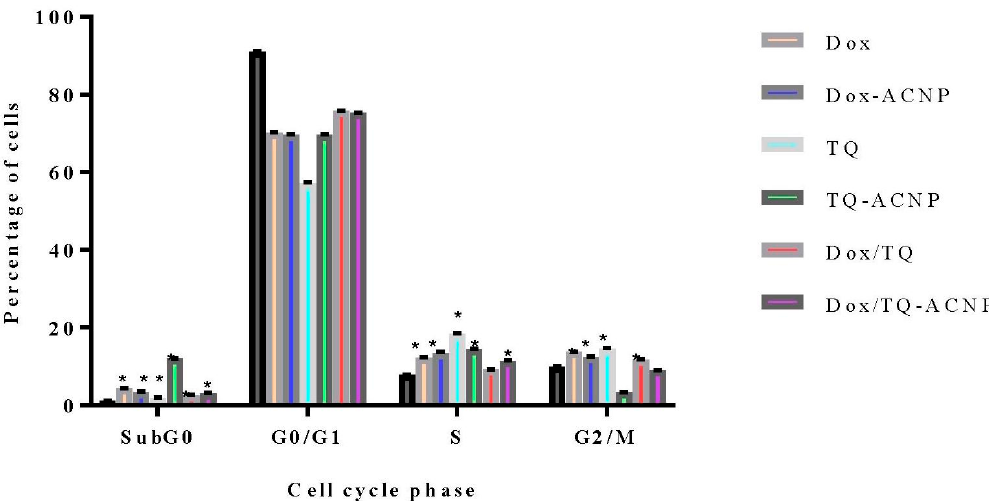
Figure 19. Graphical representation of the effect of various treatments on the cell cycle distribution of 3D mammosphere cells at 48 h.* p < 0.05 significant increase compared to control. All of the treatment caused significant S phase arrest by increasing its cell population from 7.8% (Control) to 12.15% (Dox), 13.4% (Dox-ACNP), 18.35% (TQ), 14.4% (TQ-ACNP), 9.15% (Dox/TQ) and 11.4% (Dox/TQ-ACNP). TQ and TQ-ACNP had the largest effect on S phase (18.35% and 14.4% increase in cell population, respectively), while Dox/TQ-ACNP and Dox/TQ had the least effect (11.4% and 9.15%, respectively). The percentage of cells in the G2/M phase was increased in Dox, Dox-ACNP, TQ and Dox/TQ (13.6%, 12.3%, 14.55%, 11.7%, respectively) compared to control (9.8%), signifying cycle arrest in G2/M phase. After 48 h, all treatment options induced a significant increase in the subG0 cell population. 3. Materials and Methods 3.1. Preparation of ACNP and Drug loading The preparation of ACNPs, drug loading of thymoquinone (Tokyo chemical industry, Tokyo Japan) and doxorubicin (Cayman Chemical, Ann Arbor, MI, USA), characterization of Dox-ACNP, TQ-ACNP and Dox/TQ-ACNP were carried out in accordance with Ibiyeye et al. [48]. 3.2. Generation of 3D Mammosphere from MDA MB 231 For mammosphere culture, MDA MB 231 cells (ATCC, Manassas, VA, USA) with less than ten passages were grown to about 70%–80% confluence and then enzymatically detached with trypsin (Nacalai Tesque, Kyoto, Japan), gently pipetted and suspended into single cells and passed through a 40 µm cell strainer (Corning, Lowell, MA, USA). A quantity of 1 mL of MDA MB 231 cells suspension was cultured in 24 well ultra-low attachment plates (Corning, Lowell, MA, USA ) at 20,000 cells/mL in Mammocult complete media (Stem Cell Technologies, Vancouver, BC, Canada) supplemented with 4 µg/mL of heparin solution (Stem Cell Technologies, Vancouver, BC, Canada), 0.48 µg/mL hydrocortisone stock solution (Stem Cell Technologies, Vancouver, BC, Canada) , and 1% antibiotics (Nacalai Tesque, Kyoto, Japan). After 7 days of culture in the incubator in 5% CO 2 and at 37 °C, mammospheres were used for further experiment [29]. 3.3. Drug Sensitivity Assays